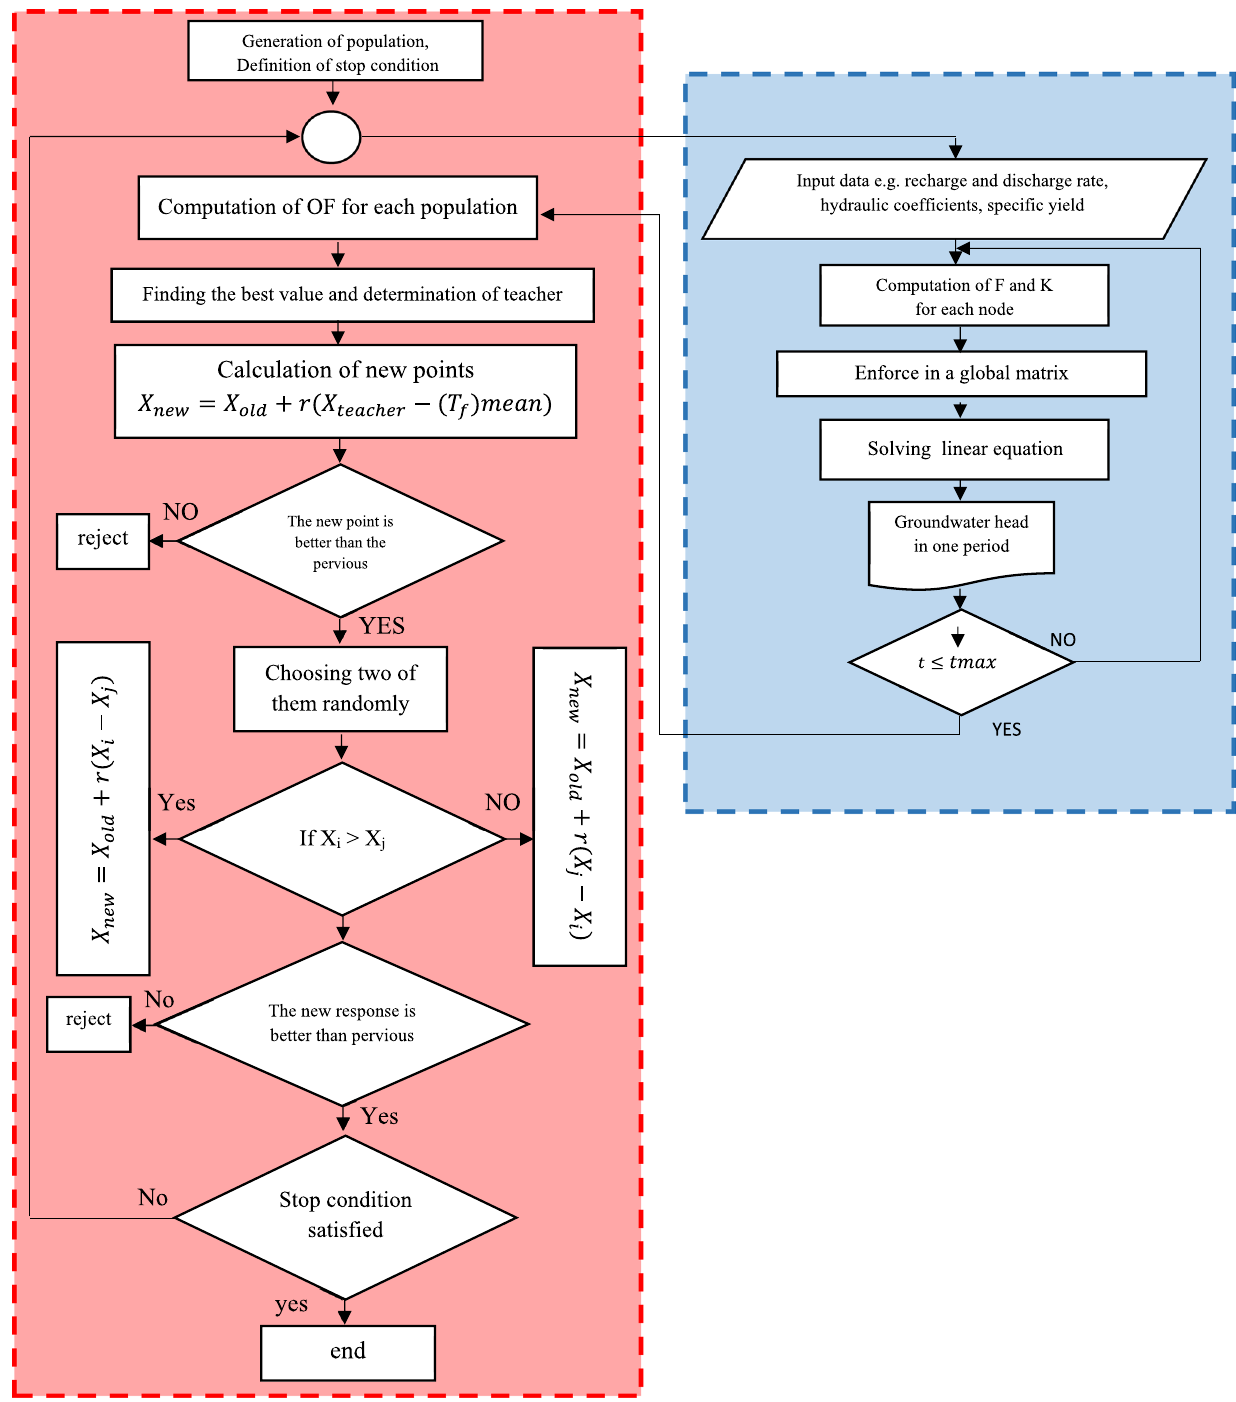
Fig. 4 Flowchart of MLPG-TLBO gray lines represent the water levels observed during mod- eling period, modeled by the meshless model and found by the finite difference method, respectively. In all diagrams, the meshless model yielded better and more accurate results than the finite difference method due to its independence